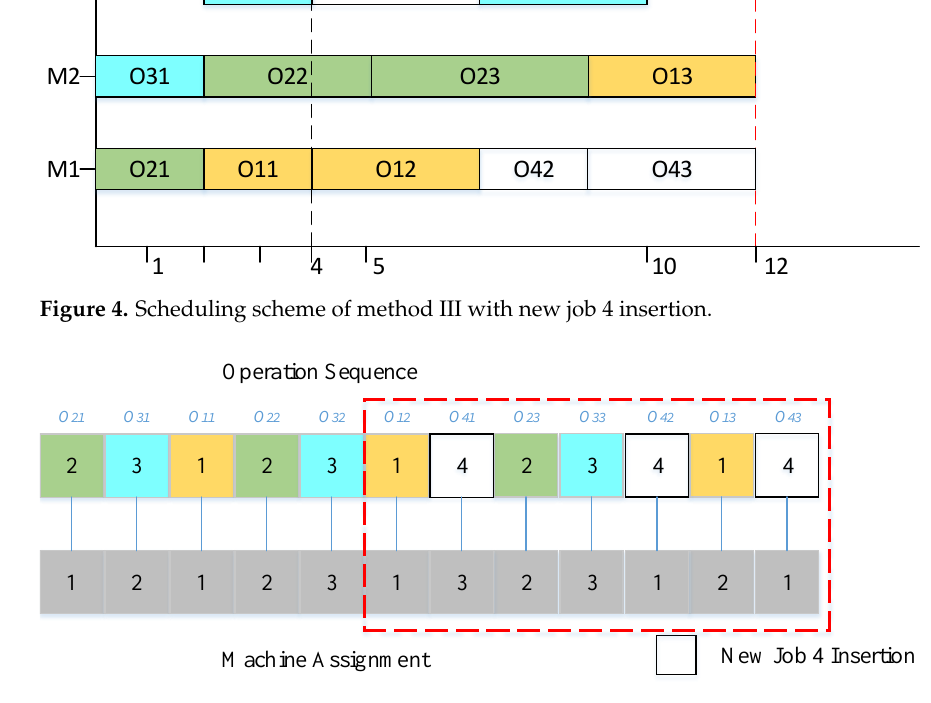
Figure 5. The coded representation with new job insertion of Figure